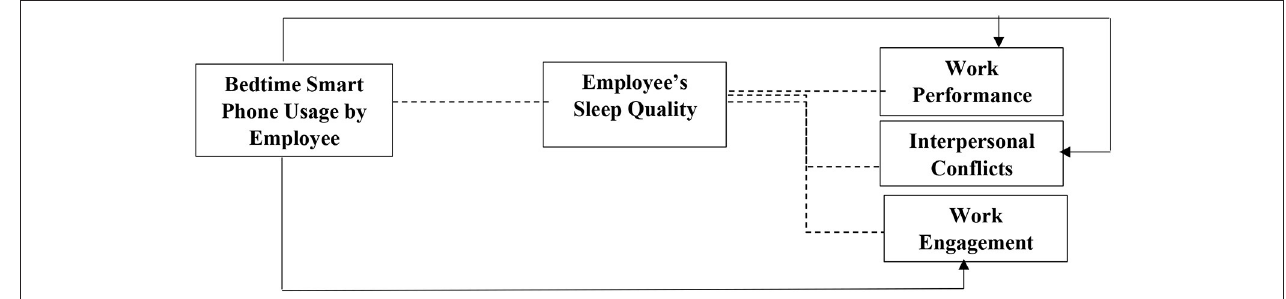
FIGURE 1 | Research model. Solid lines represent direct relationships whereas dashed lines represent indirect